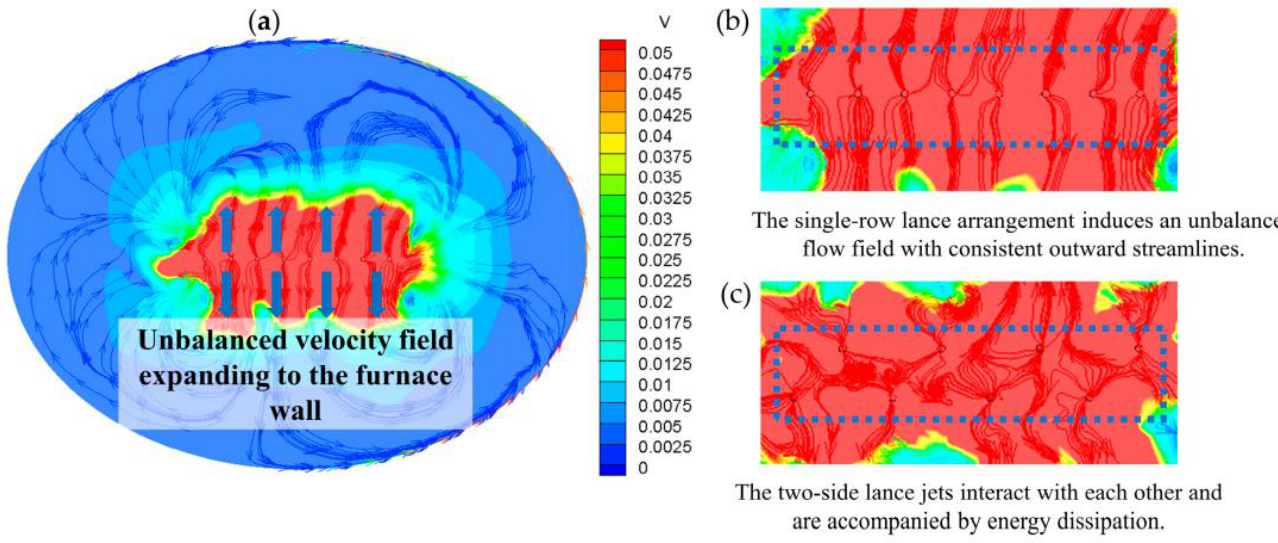
Figure 12. SA enhanced mixing mechanism: ( a ) Unbalanced flow field of SA slag phase; ( b ) stream- lines of SA slag phase; ( c ) Energy dissipation in DA localization.